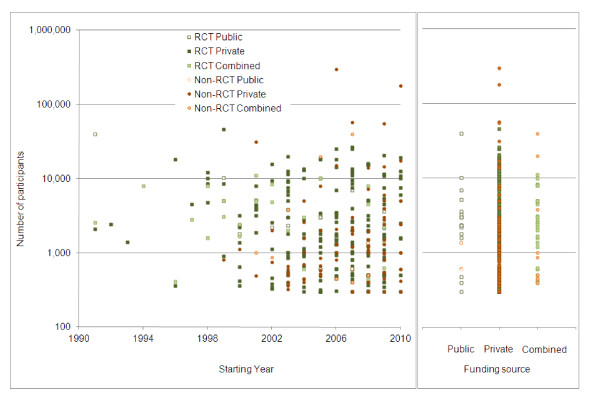
Dot plot by starting year, funding source, and number of participants.